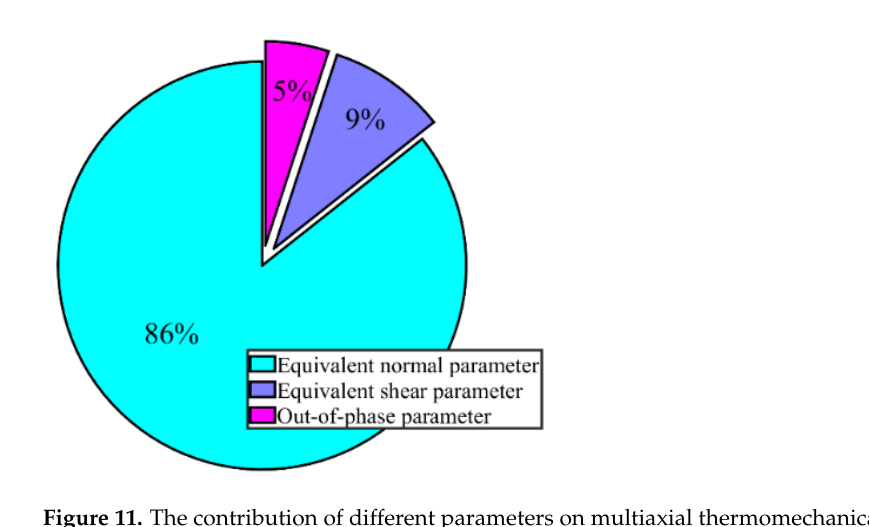
11 Figure 10. Fatigue parameter comparison between rotating loading and equivalent methods. It is discussed above that the amplitudes and distributions of temperature, stress and strain items are not enough for accurate thermomechanical fatigue evaluation of the brake disc. Ignoring the influence of the multiaxial character and out-of-phase feature leads to an underestimation of the thermomechanical fatigue assessment for the brake disc. Based on the result with the rotating loading calculation, the contribution of the equivalent shear parameter, equivalent normal parameter and out-of-phase parameter (represented by P1 , P2 and P3 in the MFS criterion) to the total multiaxial thermomechanical fatigue parame-